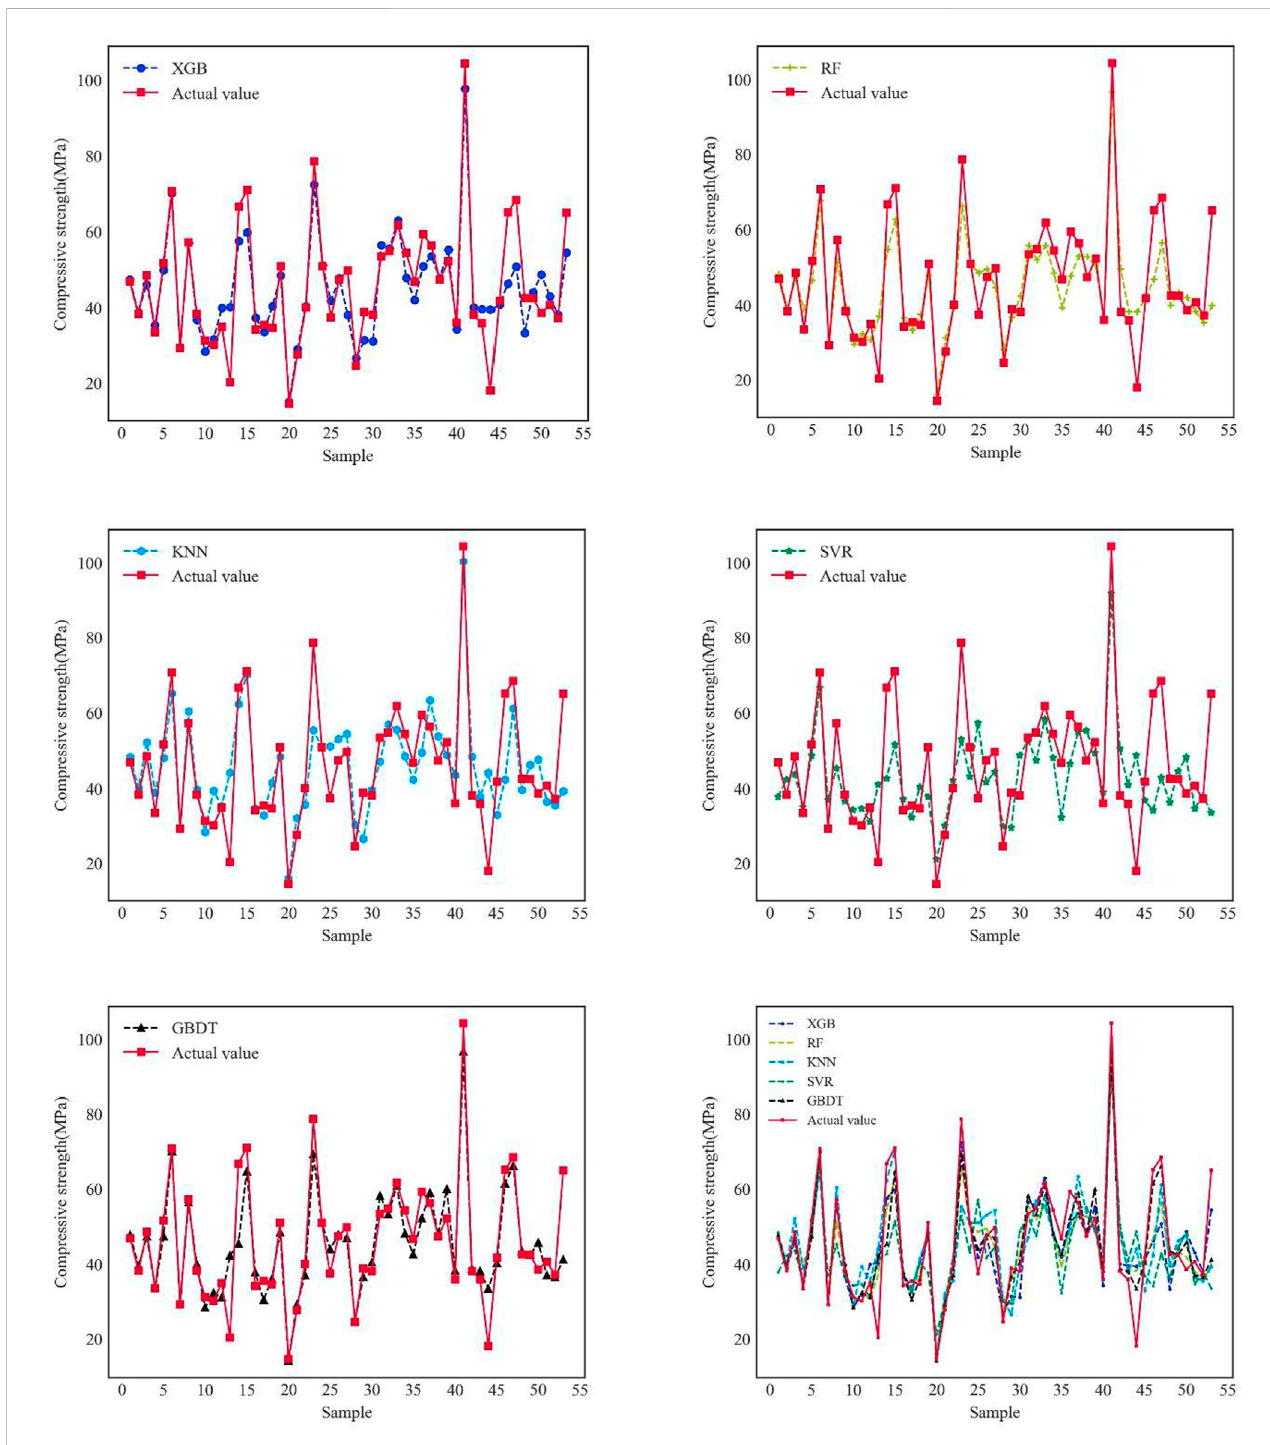
FIGURE 10 Comparison of predicted values of